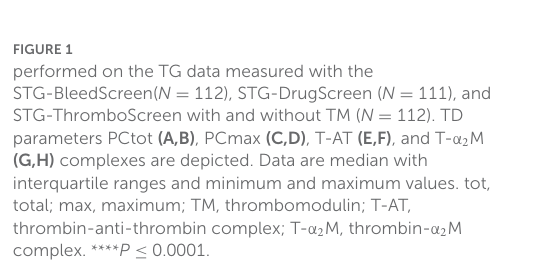
TABLE 2 Reference ranges for thrombin dynamics parameters determined on the ST